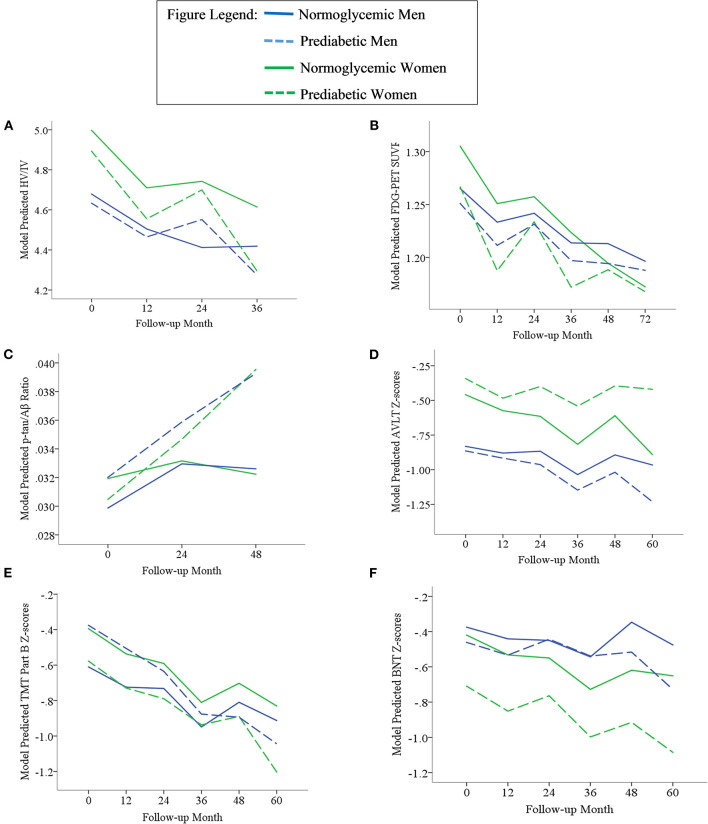
Trajectories of AD biomarkers (A–C) and cognitive test z-scores (D–F) by prediabetes status and sex in the overall sample. TMT Part B z-scores were multiplied by −1 so that higher scores indicated better performance. Z-scores are age- and education-adjusted based on a normative control group that remained cognitively normal throughout follow-up in ADNI. HV/IV, ratio of hippocampal volume to intracranial volume; PET, positron emission tomography; FDG, fludeoxyglucose; SUVR, standaradized uptake volume ratio; p-tau, phosphorylated tau; Aβ, amyloid beta; BNT, Bostin Naming Test; TMT, Trail Making Test; AVLT, Rey Auditory Verbal Learning Test.